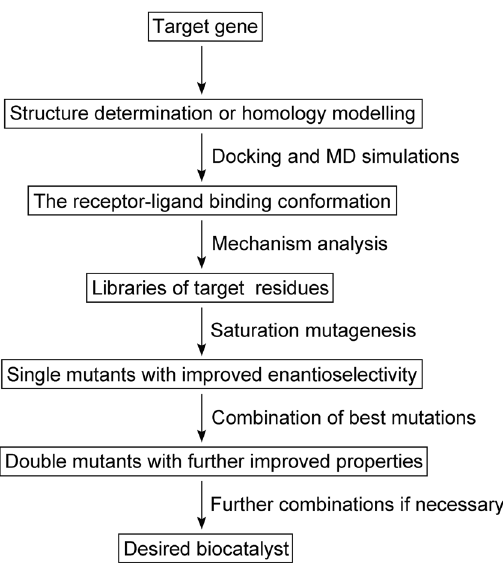
Figure 6. A flowchart of the semi-rational engineering of an enantioselective